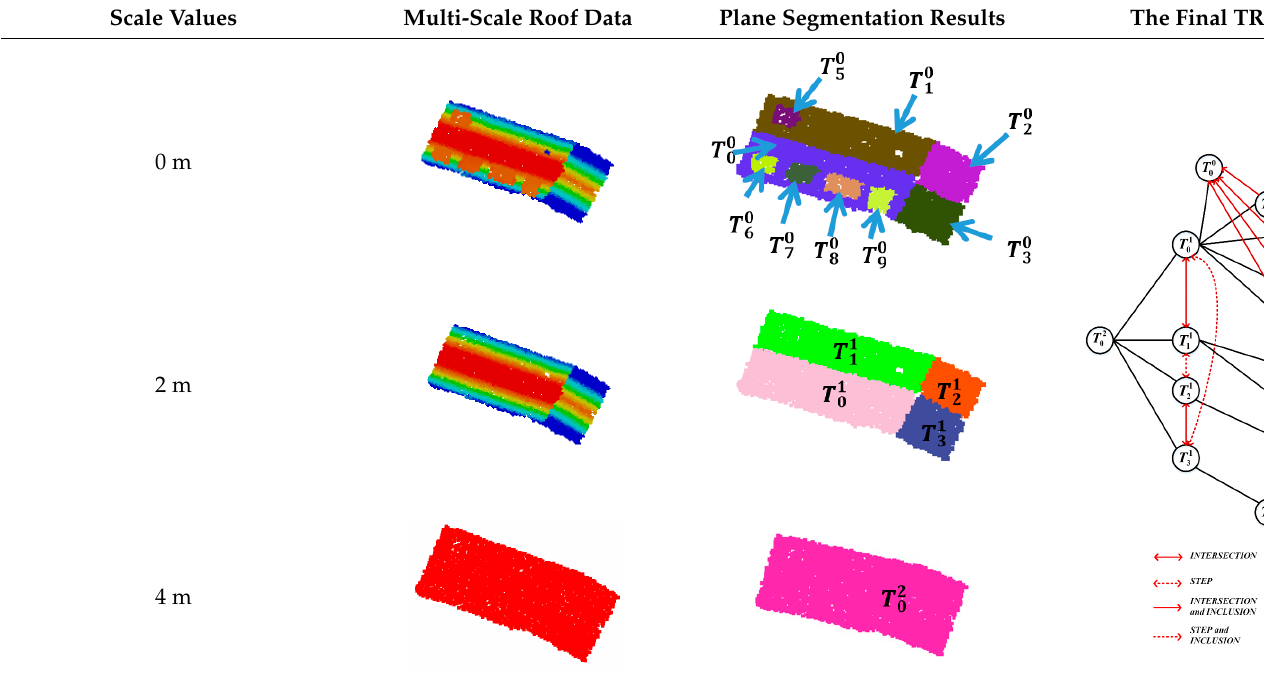
Table 3. Second example of generating the LoDs for a building with gable roofs and dormers.